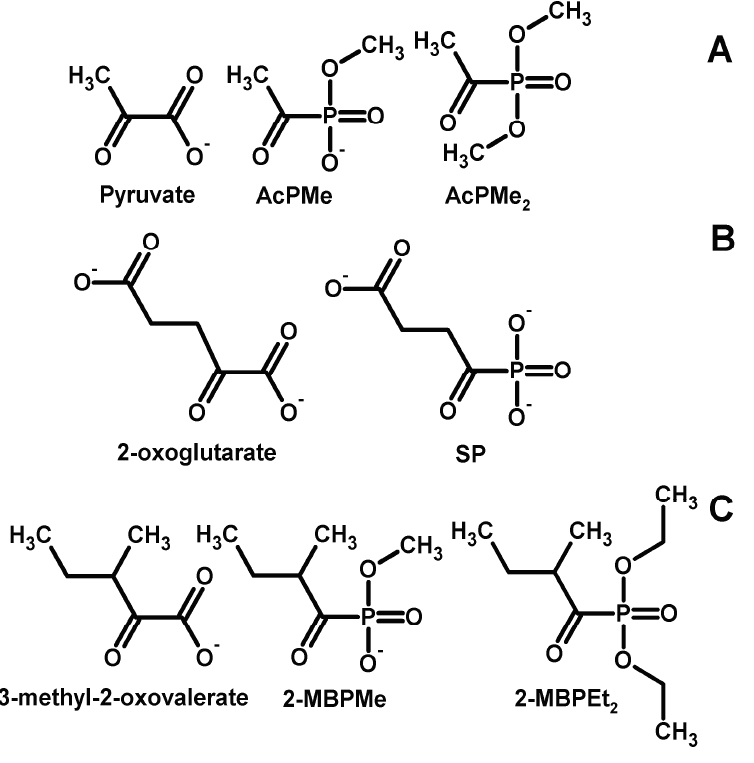
Figure 4. Structures of the 2-oxo acids and their phosphonate analogs used in this work. ( A ) Pyruvate and its analogs: methyl ester of acetyl phosphonate (AcPMe) and dimethyl ester of acetyl phosphonate (AcPMe 2 ); ( B ) 2-oxoglutarate and its analog, succinyl phosphonate (SP); ( C ) 3-methyl-2-oxo-valerate (“ketoisoleucine”) and its analogs, methyl ester of 2-methylbutyryl phosphonate (2-MBPMe) and diethyl ester of 2-methylbutyryl phosphonate (2-MBPEt 2